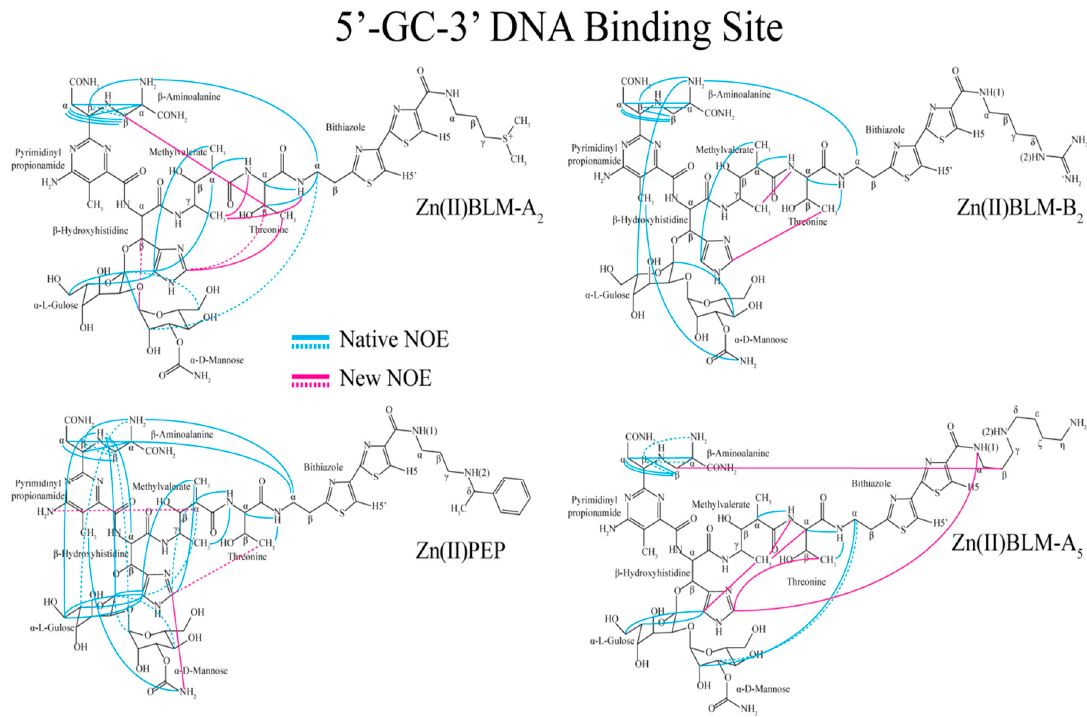
Figure 5. Inter-residue intramolecular NOEs for each OL 1 -bound Zn(II)BLMs. Samples of Zn(II)BLMs:OL 1 are in a 1:1 molar ratio in H 2 O at 5 °C. Dashed and continuous lines all represent NOE connectivities, they are used to avoid confusion in busy sectors of the figure.